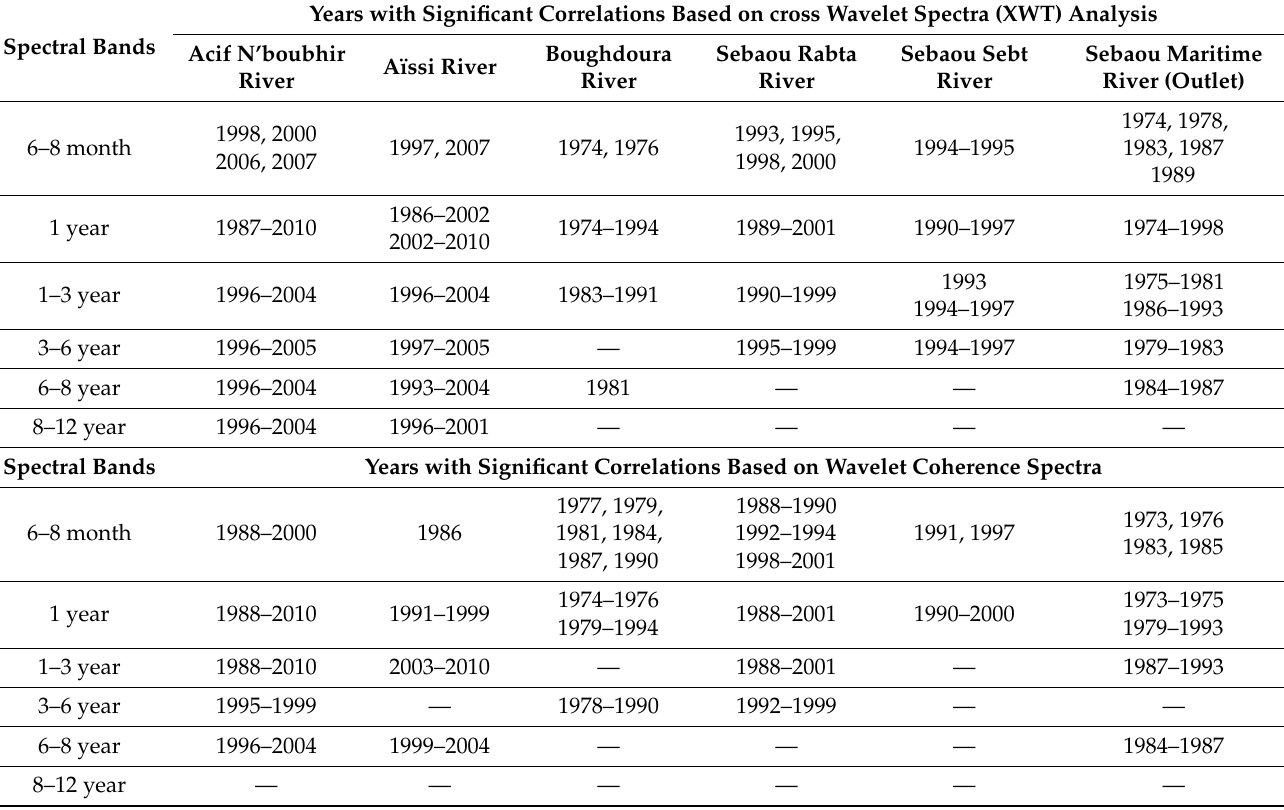
Table 4. Extracted significant correlations between daily rainfall and streamflow time series using XWT and WCT.